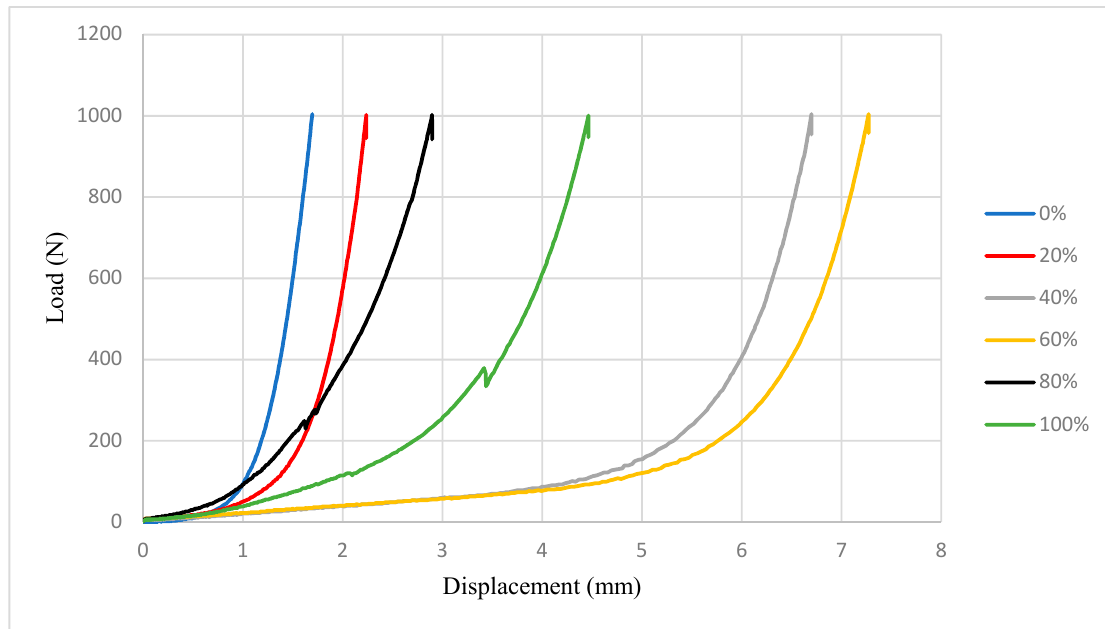
Figure 8. Result of the load x displacement curve at different mortar replacement levels.